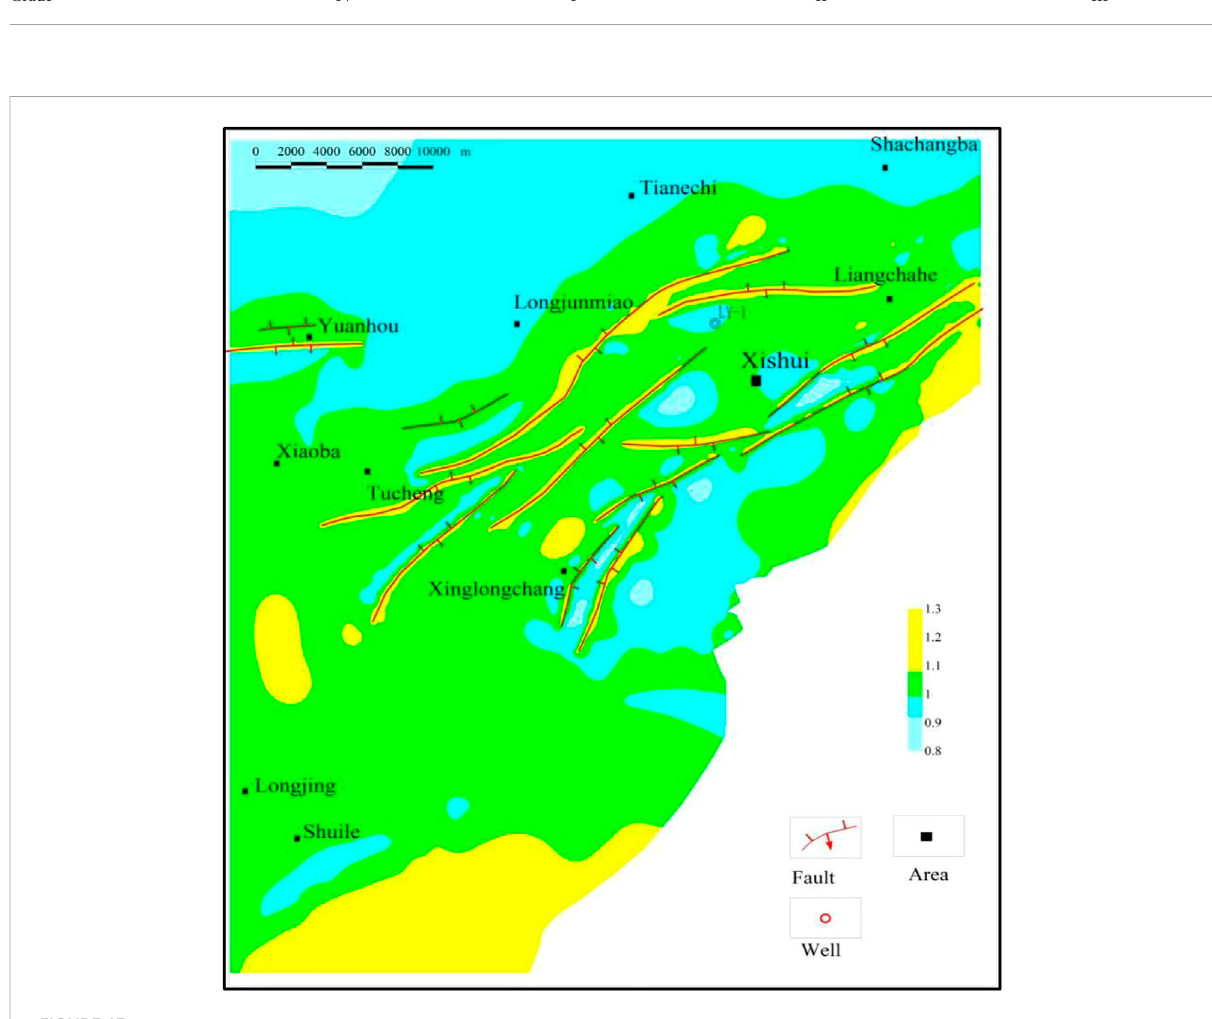
FIGURE 13 Prediction results of fracture development area in Lintanchang